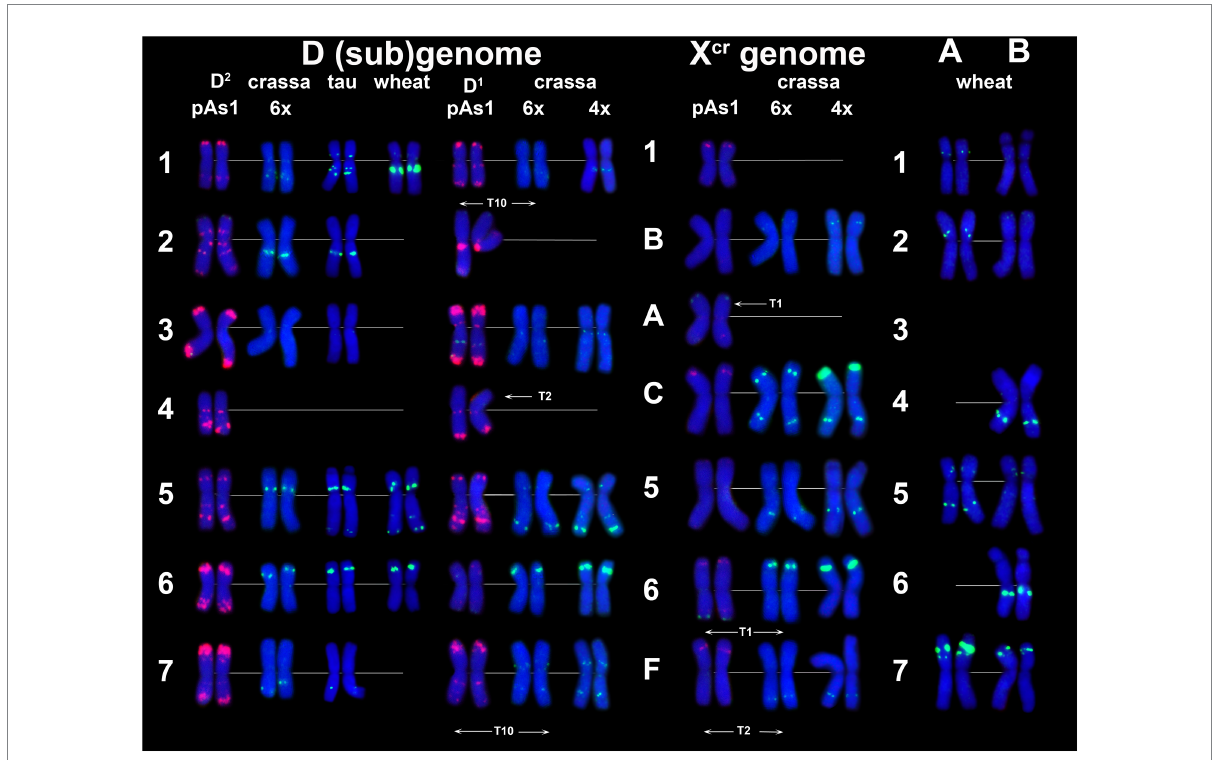
FIGURE 8 Comparison of P332 labeling patterns on chromosomes of different cereal species. D (sub)genome: D 2 – subgenome of 6x Ae . crassa ; TAU – Ae . tauschii ssp. tauschii; wheat – Chinese spring; D 1 – subgenomes of tetraploid (4x) and hexaploid (6x) Ae . crassa ; X cr – subgenomes of